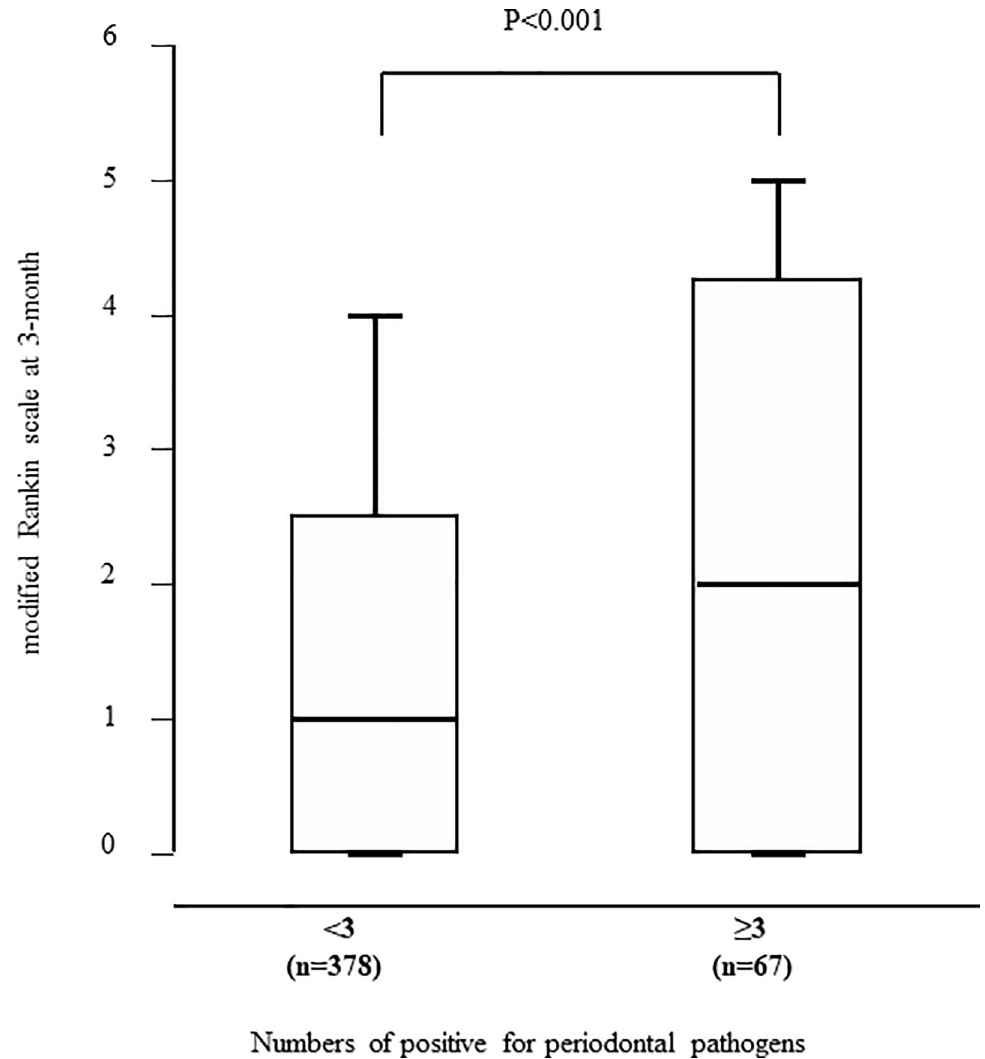
Fig 1. Relationship between the mRS at 3-months and numbers of IgG antibodies positive for periodontal pathogens. The mRS at 3-months was significantly higher in patients with � 3 positive for periodontal pathogens than in those with < 3 positive for periodontal